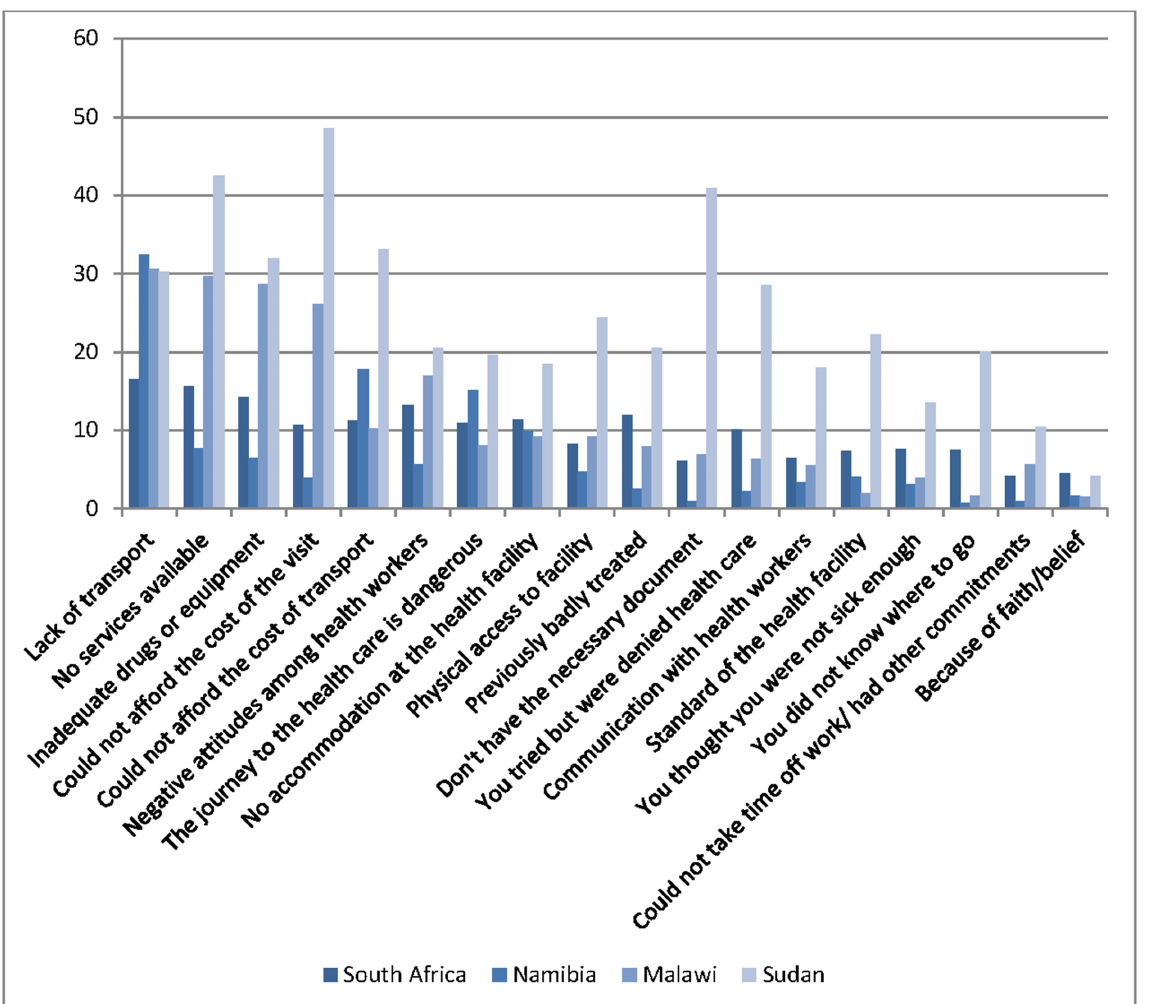
Fig 2. Serious or insurmountable problems in accessing health care, by country.